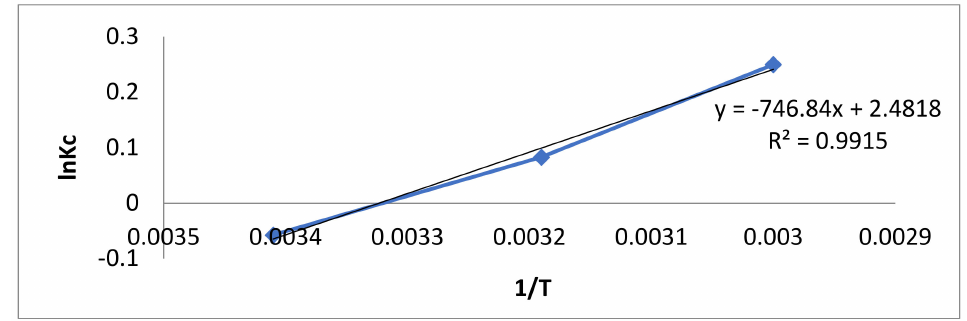
Figure 8. Van’t Hoff plot of BB-3 adsorption on ternary composite. At different temperatures, the Gibbs free energy change ( ∆ G ◦ ) was found to be neg- ative, indicating that the adsorption process was feasible and spontaneous. The decline in ∆ G ◦ values was found as temperature increased, indicating that the adsorption pro- cess occurs more favorably at lower temperatures [88]. The increased randomness at the dye/adsorbent interfaces and a strong affinity for the adsorption were verified by the positive value of change in enthalpy ( ∆ H ◦ ) [89]. During adsorption, a positive entropy change ( ∆ S ◦ ) indicated increased disorder at the solid–solution